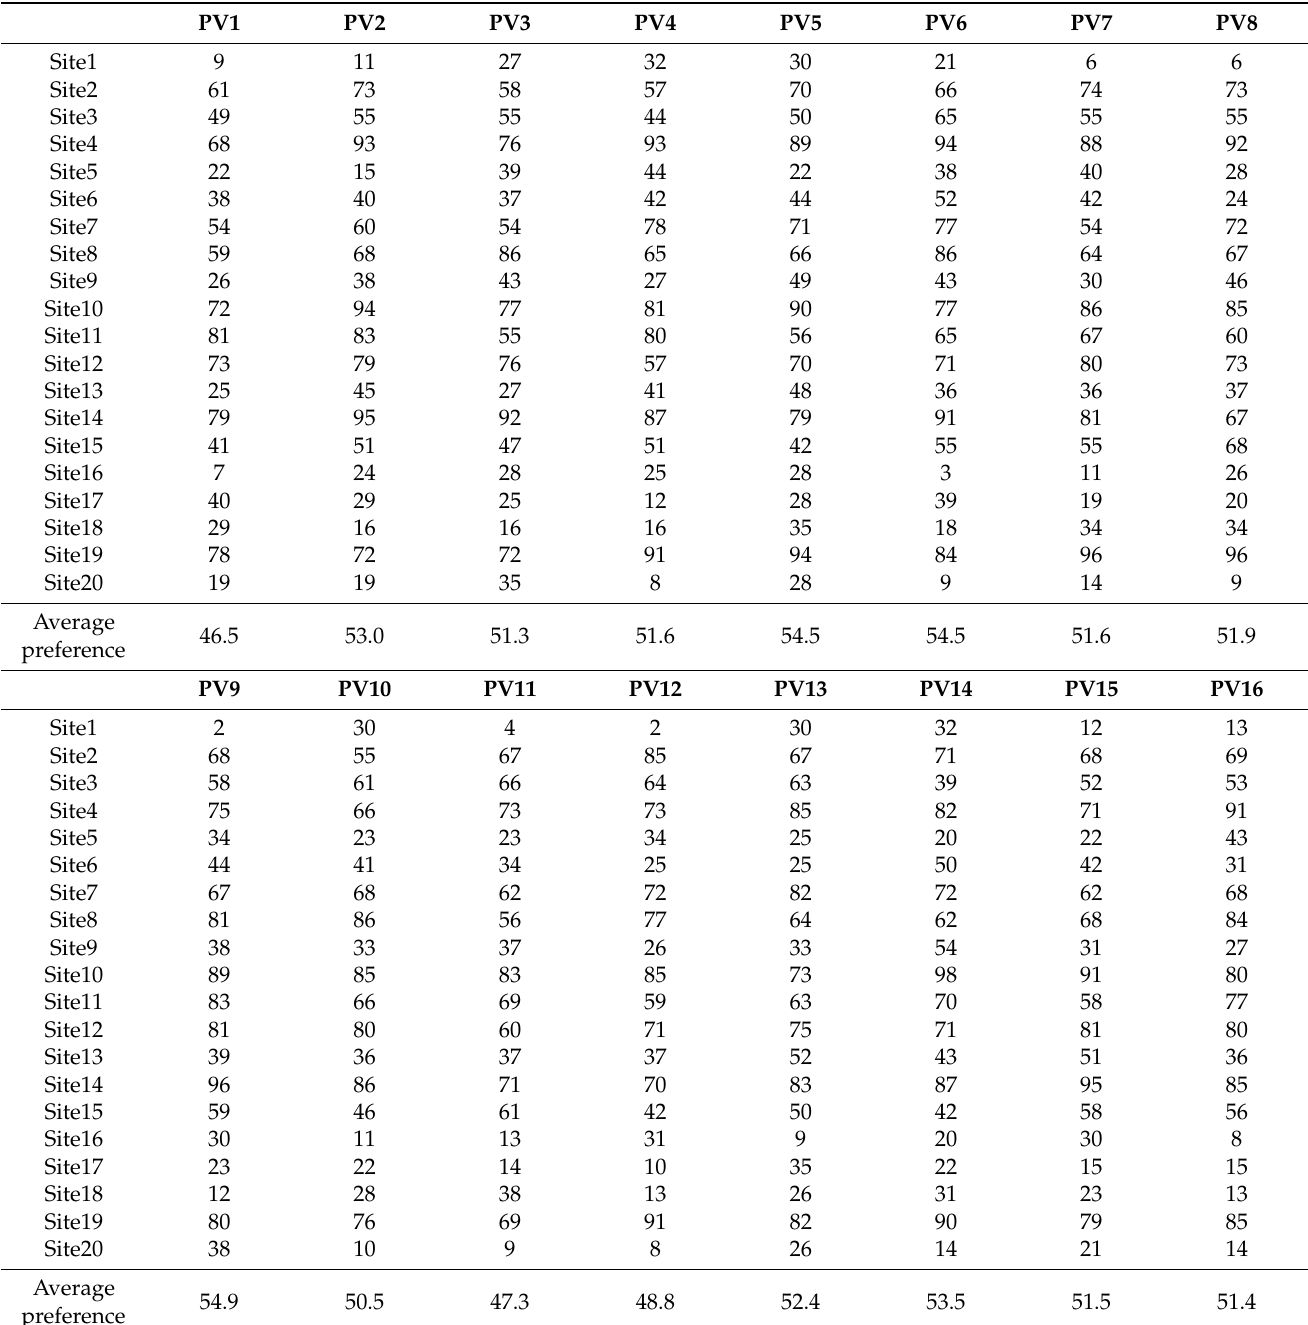
Table 4. Assumptions of levels of preferences of stakeholders. PV procurement companies’ levels of preference for sites for each PV